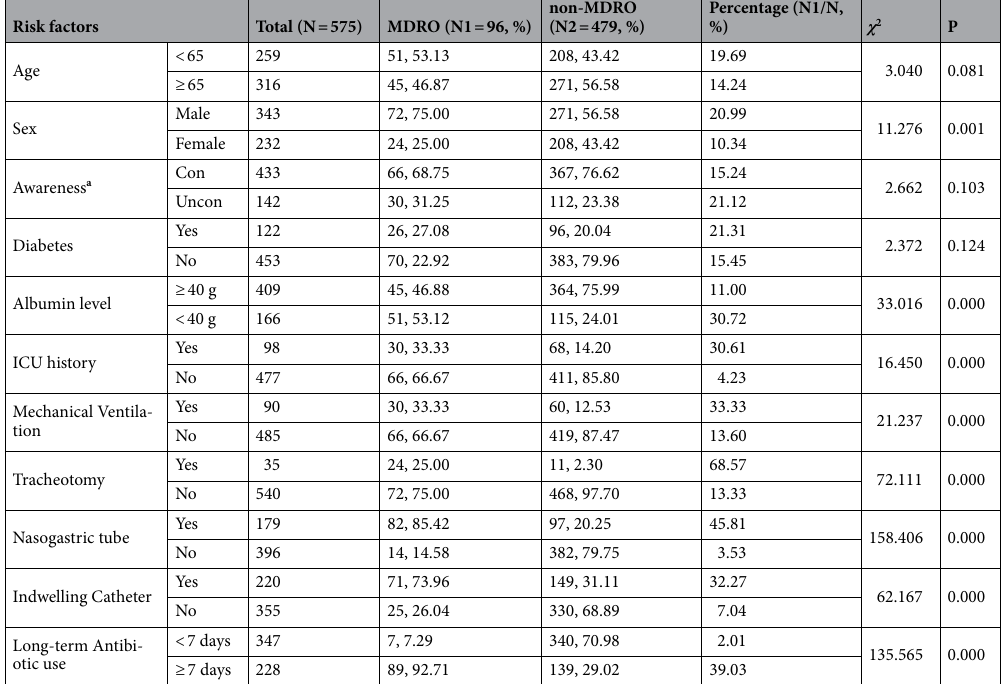
Table 4. Risk factors for MDRO-related infection in neurorehabilitation ward. a The awareness was assessed using CRS-R and GCS. CRS-R Coma Recovery Scale—Revised, GCS Glasgow Coma Scale, con conscious, uncon nonconscious, ICU intensive care unit.